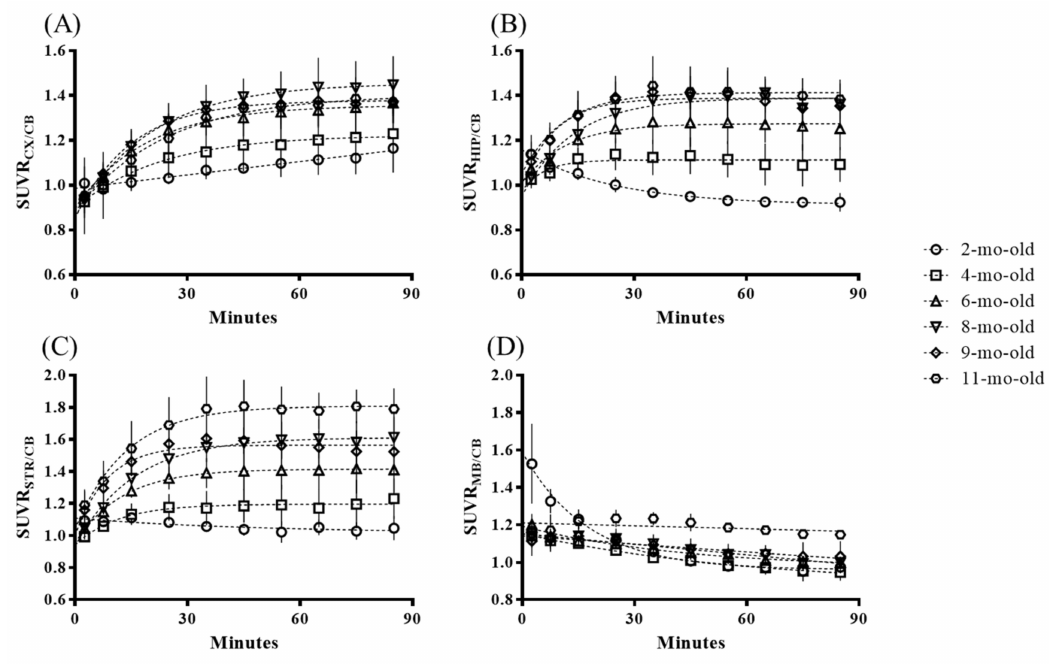
Figure 1. Mean regional standardized uptake value ratios (SUVR) time–activity curve of ( A ) cortex, ( B ) hippocampus, and ( C ) striatum, and ( D ) midbrain for each age group in the dynamic PET imaging acquisition studies. CX: cortex, HIP: hippocampus, MB: midbrain, STR: striatum, CB: